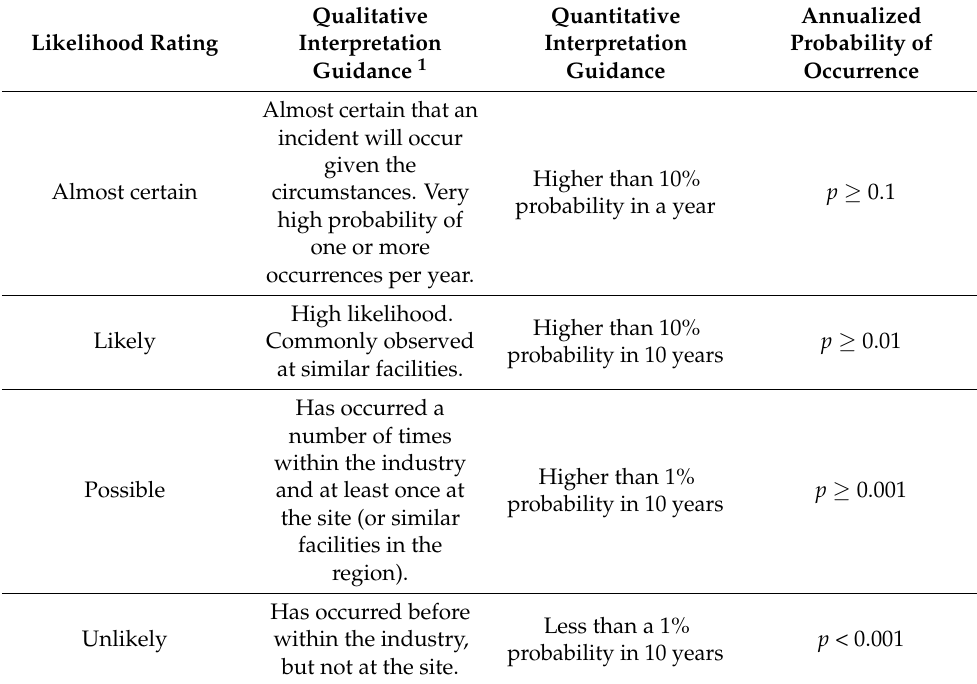
Table 1. Likelihood rating (Reprinted from Schafer et al.